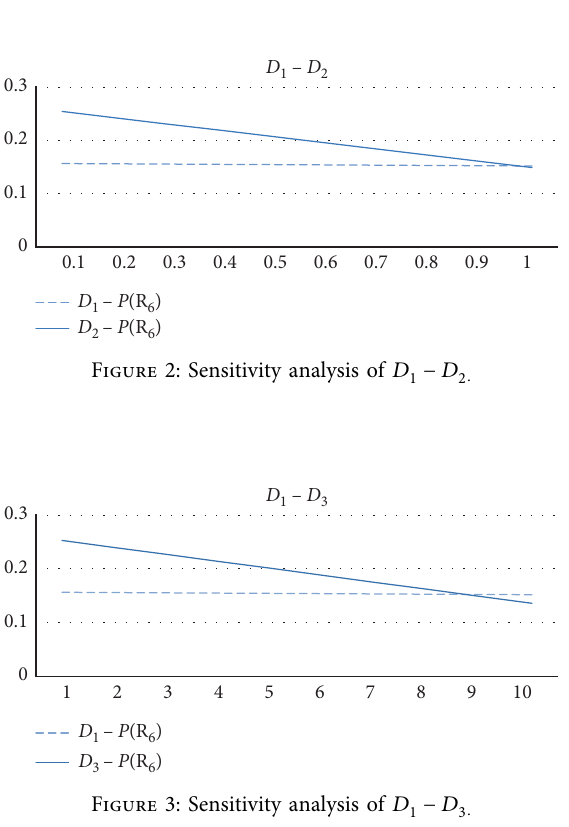
Figure 3: Sensitivity analysis of D